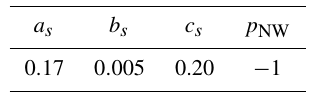
Table 2. Fitted parameters: wake expansion and near-wake correc- tion.